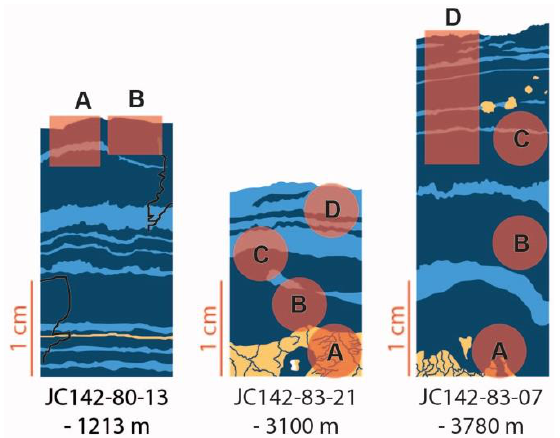
Figure 2. Simplified schematic diagrams of the hand specimens from which the samples were taken, showing the textural variations visible and the locations of the X-ray computed tomography (XRCT) cores drilled in each sample. The dark blue represents dense, pillared areas in the hand specimens, while the lighter blue represents more chaotic, cuspate texture, as visible in the hand specimens. The yellow areas are carbonate basement.